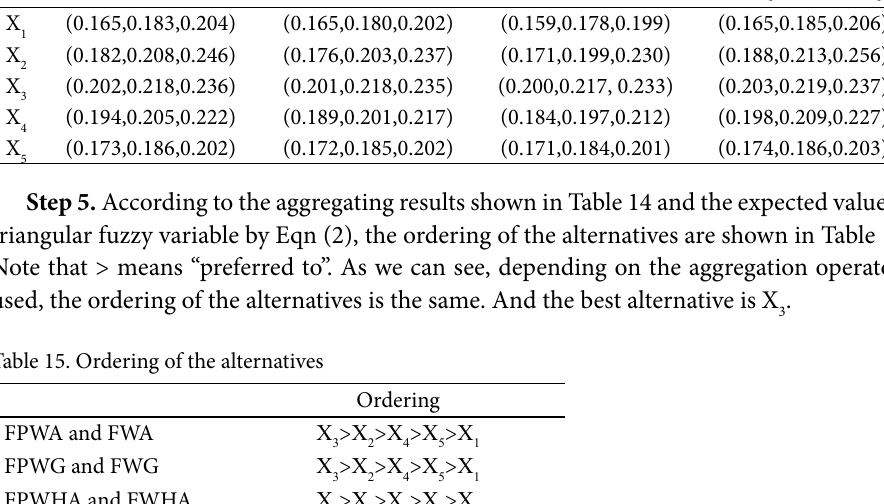
Table 14. The overall preference values of the alternatives FPWA and FWA FPWG and FWG FPWHA and FWHA FPWQA and FWQA